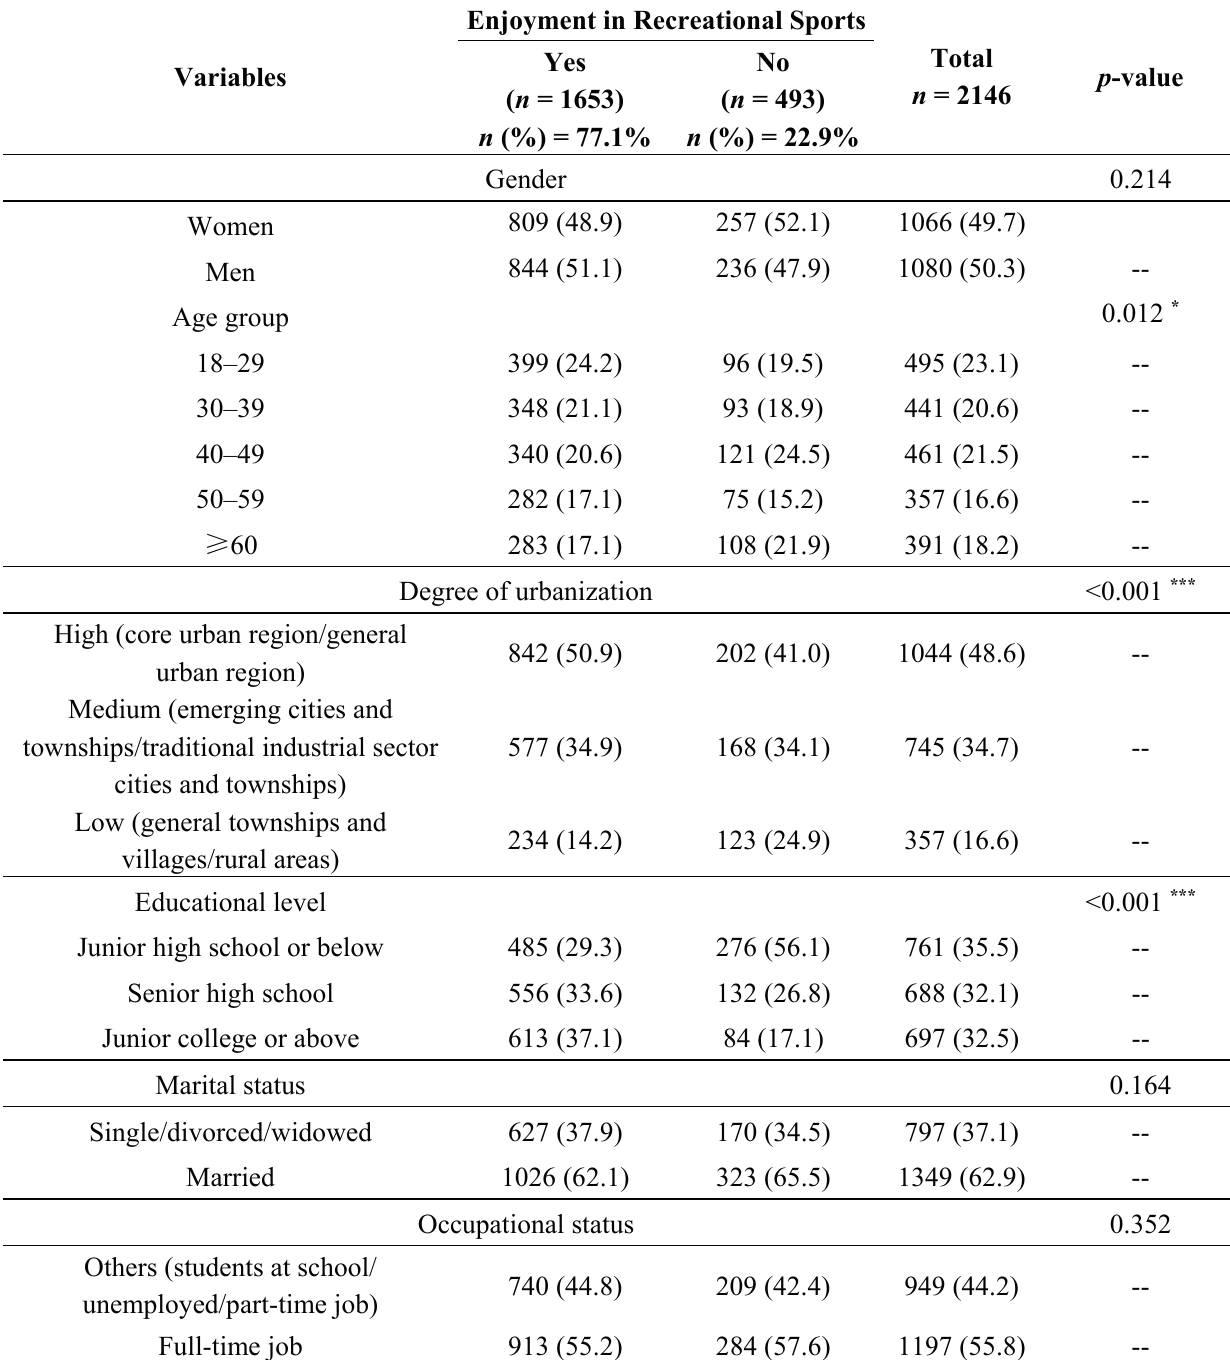
Table 1. Participants’ characteristics and survey responses ( n =